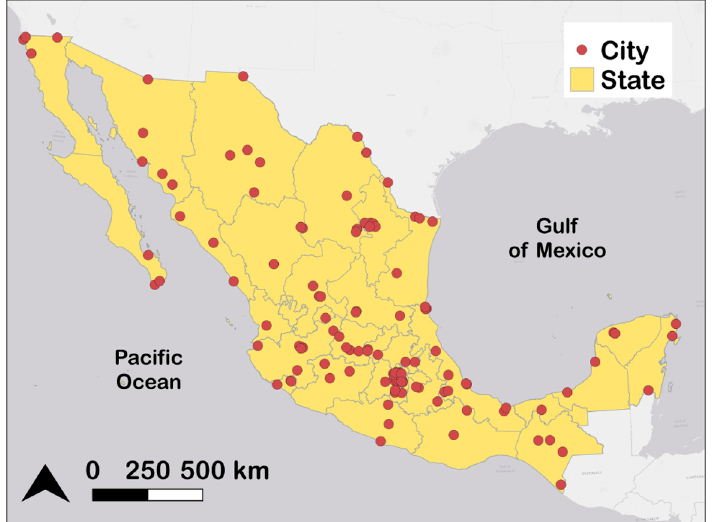
Figure 1. Distribution of the 145 cities with more than 100,000 inhabitants in Mexico according to the Census of Population and Housing for 2020.